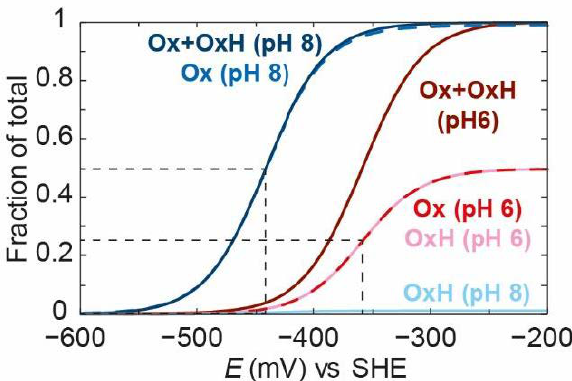
Figure 7. Variation of the fraction (out of 1) of the total oxidised ( Ox + OxH , dark blue/red), the deprotonated oxidised ( Ox , dashed blue/red), and the protonated oxidised ( OxH , light blue/red) species as a function of the applied potential at pH 6 (red) and pH 8 (blue). The curves were obtained using Equations (7), (11), (12), and (15), with E O = − 459 mV, K a, 1 = 10 − 6 ( pK a, 1 = 6), and K a, 2 = 10 − 8 1 ( pK a, 2 = 8). E O was calculated using Equation (21) to be − 341 mV, giving an average E O of − 400 mV, 2 for a comparison with Figure